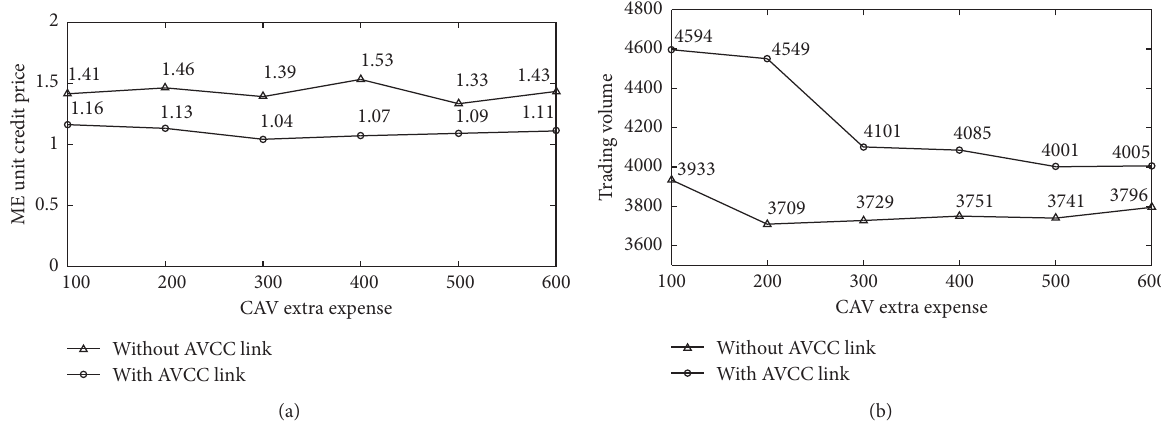
Figure 11: States of credit market under various CAV extra expenses. (a) Market equilibrium unit credit price. (b) Trading volume among